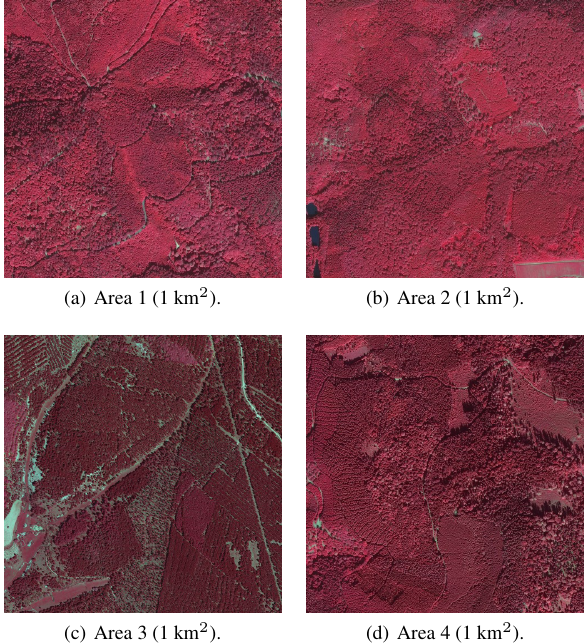
Figure 1. Orthoimages of the areas of